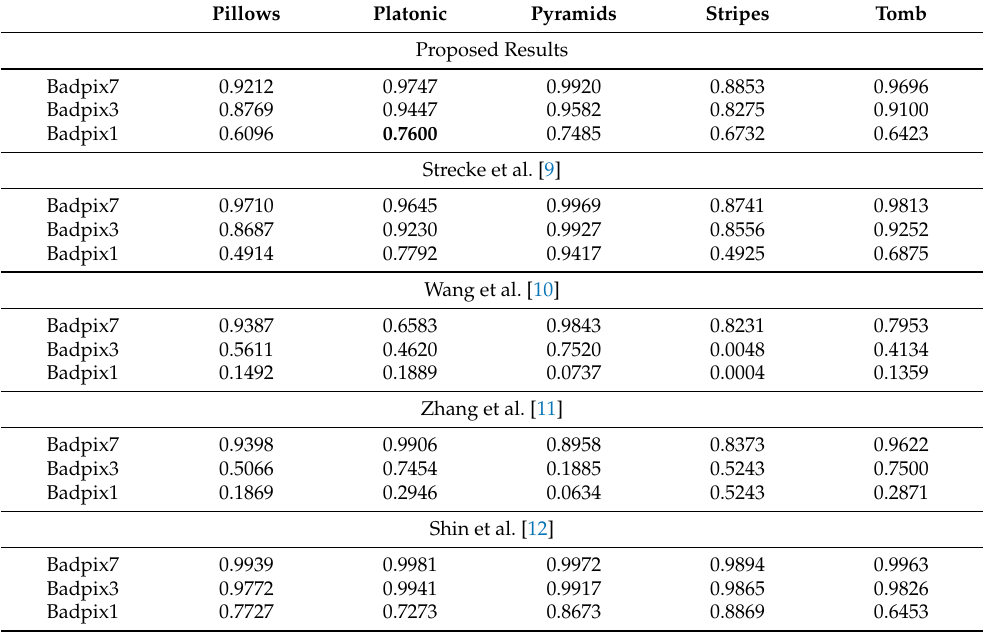
Table 3. Quantitative depth map comparison for synthetic data to ground truth for different algorithms. Pillows Platonic Pyramids Stripes Tomb Proposed Results